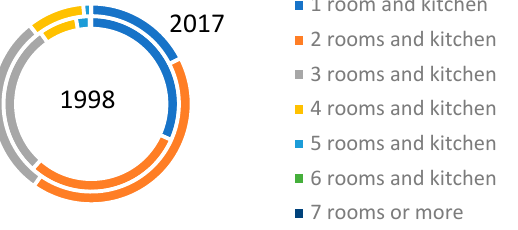
Figure 4. Apartments in new construction by type in Gothenburg region in 1998 and 2017.